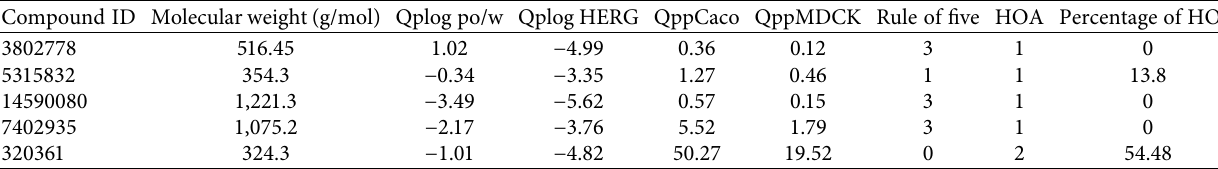
Figure 6: MESP mapping of 250395 (a), 129677029 (b), 44259583 (c), 4425984 (d), and 88583189 (e) Kabasura Kudineer compounds. The most negative electrostatic potential was colored deepest red, and the most positive electrostatic potential was colored deepest blue. The intermediate yellow, orange, and green shades indicate the ranges of reactivity. Table 5: ADME properties of the homeopathy compounds.